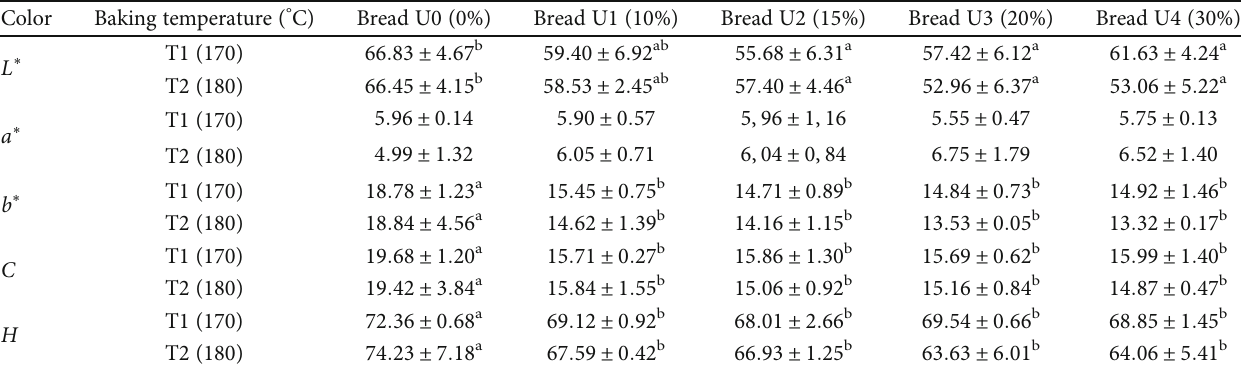
Table 2: Color of plain bread with di ff erent baking temperature and yam fl our addition.